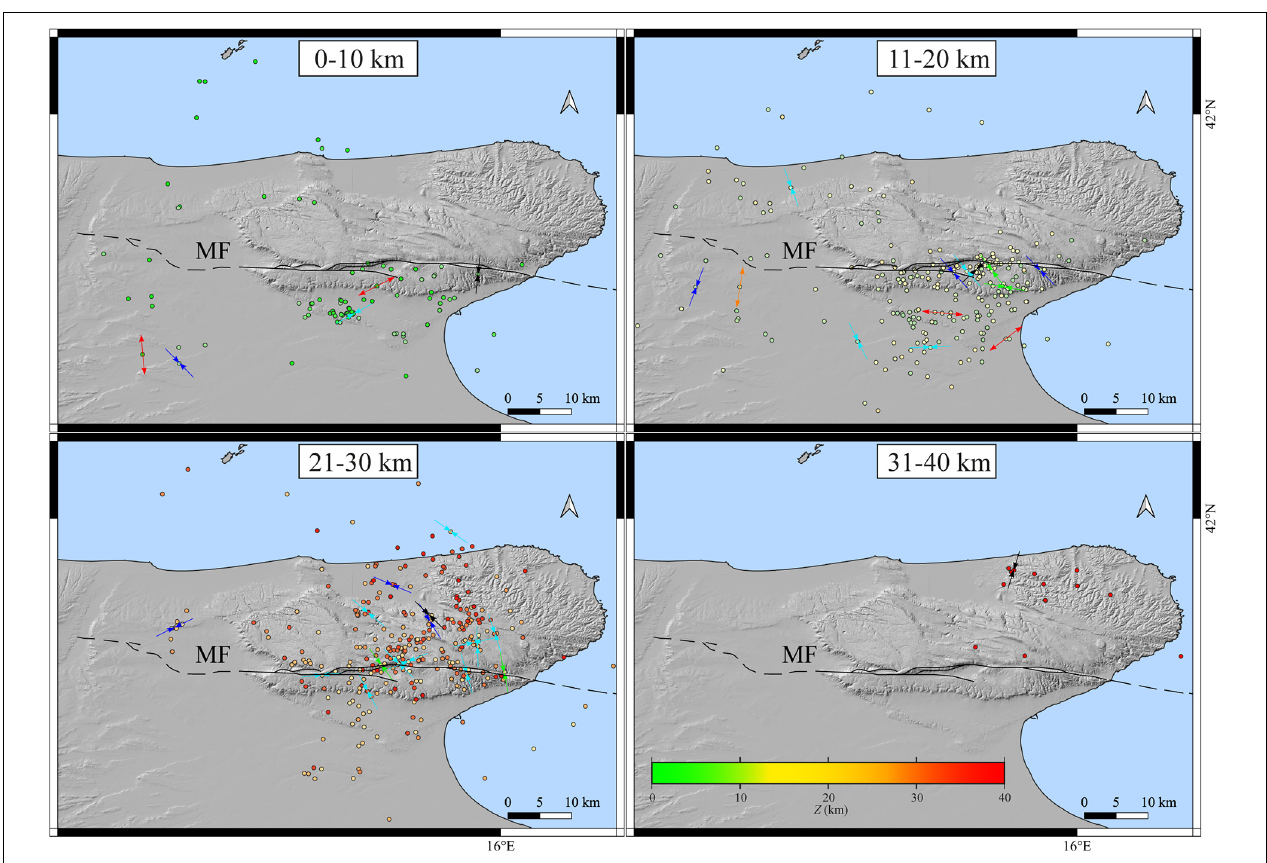
FIGURE 6 | Geographical maps of epicentral distribution of all 635 earthquakes and 36 focal mechanisms, grouped by four depth ranges, as superimposed on each map. Epicenters are colored according to depth. described the different depth ranges. The black line is the MF System as reported by Zunino et al. (2012). Arrows represent the P-T axes with colors referring to kinematics, as shown in Figure 5 .